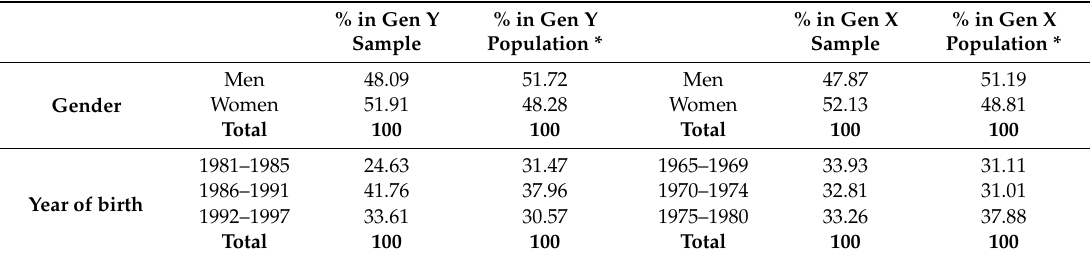
Table 2. Sample vs. population